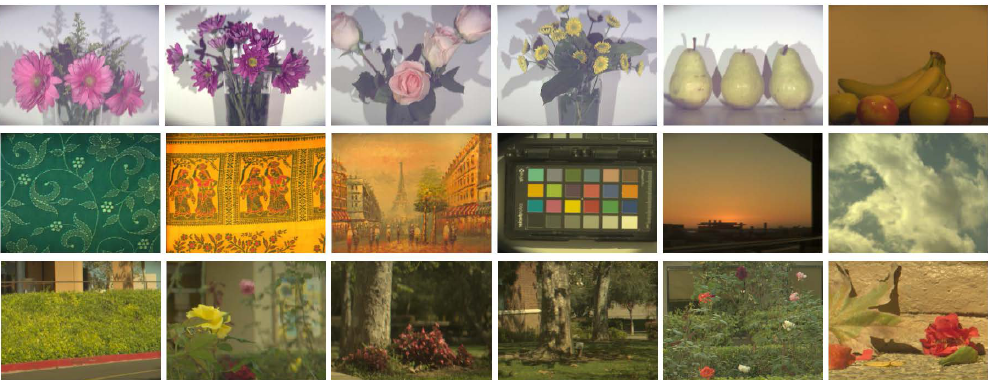
Figure 2. Several sample images of our natural multispectral images dataset. Each image was captured using an SOC-730 hyperspectral camera with a spatial resolution of 600 × 800 and 31 spectral measurements (400–700 nm) at each